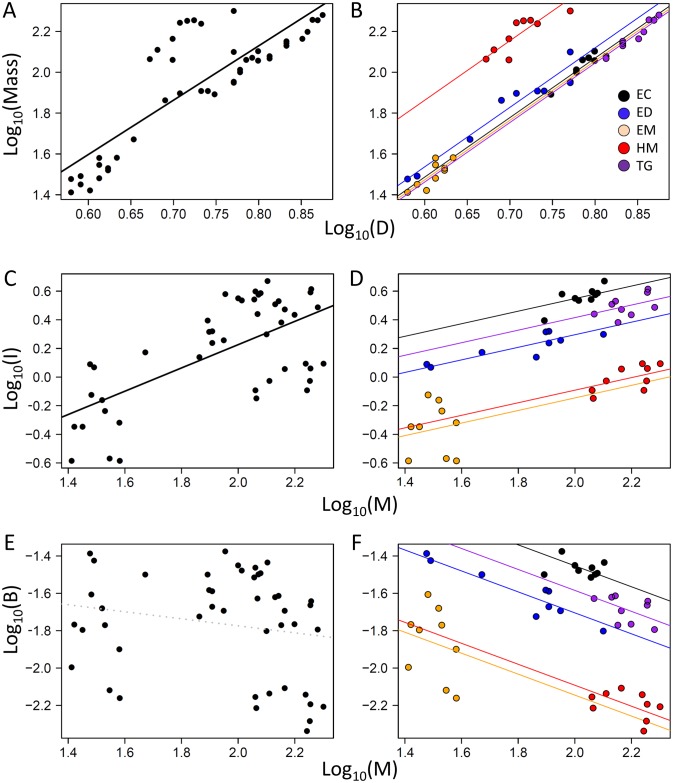
Allometric relationships of echinoid mass and metabolism.Mass (M, g) vs. test diameter (D, cm) (a-b); and individual (I, mgO2/h) (c-d) and biomass-specific (B, mgO2/g/h) (e-f) metabolic rates vs. mass. Figures on the left (a,c,e) include all individuals pooled; figures on the right (b,d,f) include species as fixed factors (slopes = homogenous). All data were Log10(x) transformed and lines represent ordinary least-square linear fits of log-log transformations (Table 2). Echinoid species codes as in Fig 1a.